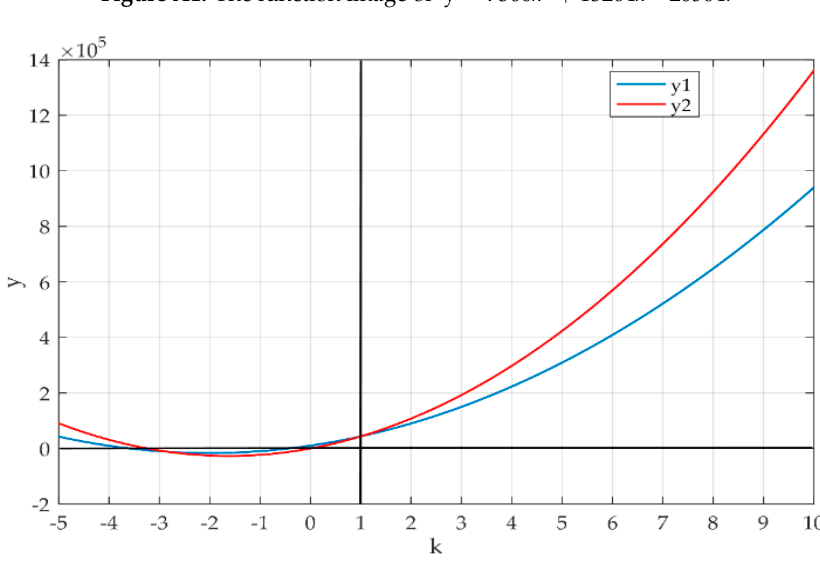
(cid:2870) + 13264𝑘 − 20564 .